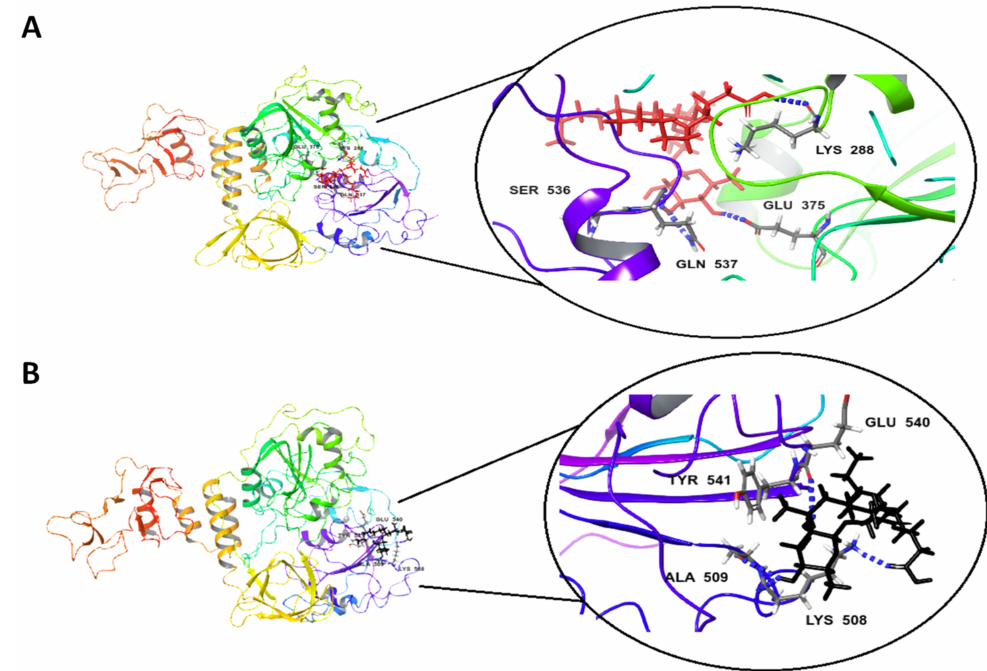
Figure 5. In silico docking study revealing interactions between ( A ) Rha(s)1 and ( B ) Rha(s)2 with the active sites of SARS-CoV-2 Helicase. PDB accession number for helicase is 5RL6.